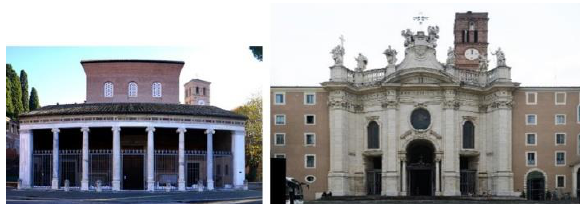
Figure 3- Two significant Churches in Rome: on the left San